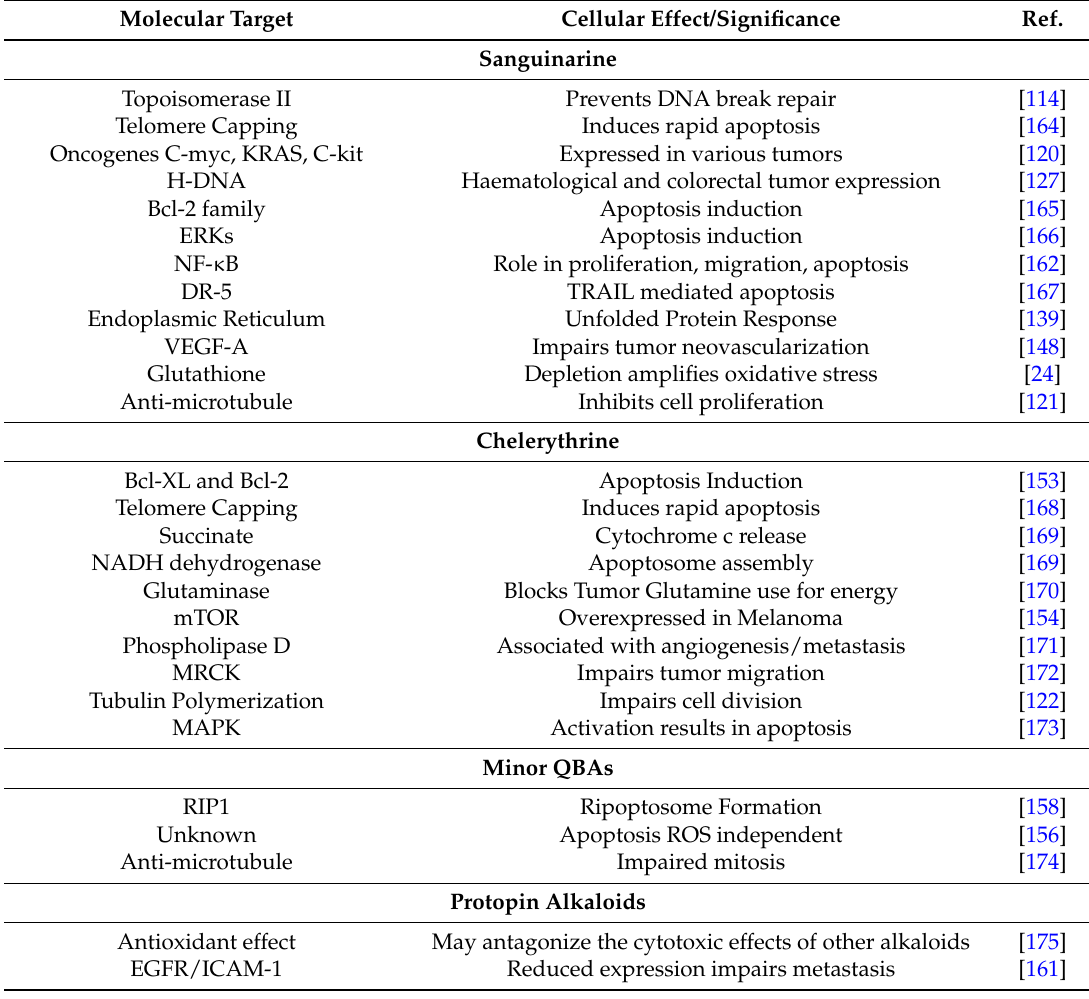
Table 2. Anticancer Effects of S. canadensis